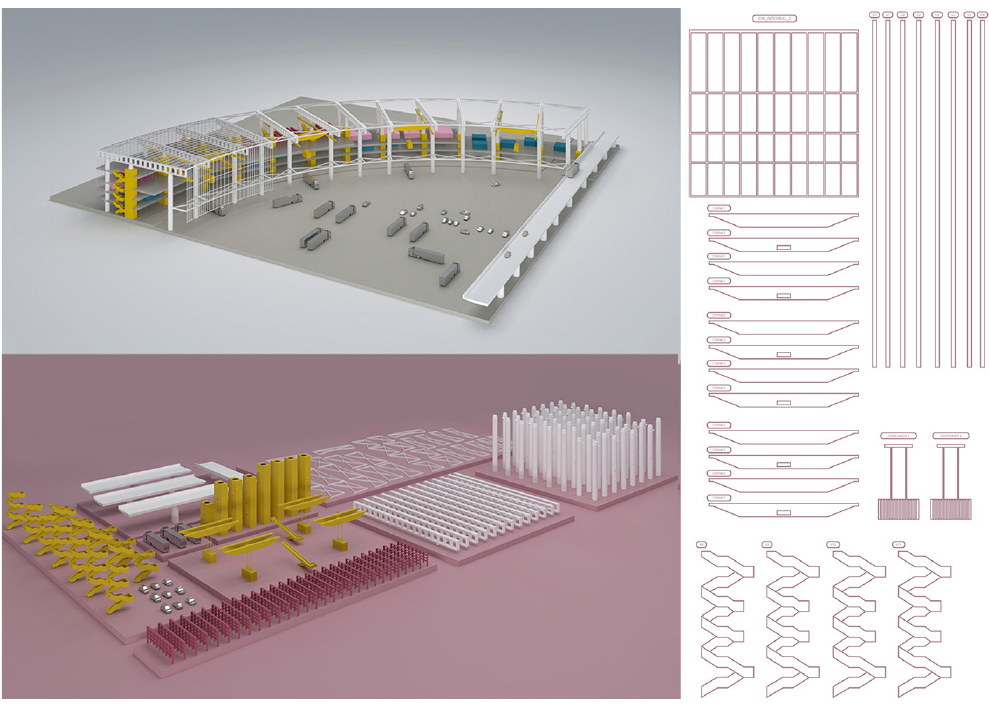
Fig. 6 Bertola, G., The 3D model: example of organization and numbering of some pieces of the model and rendering images ,